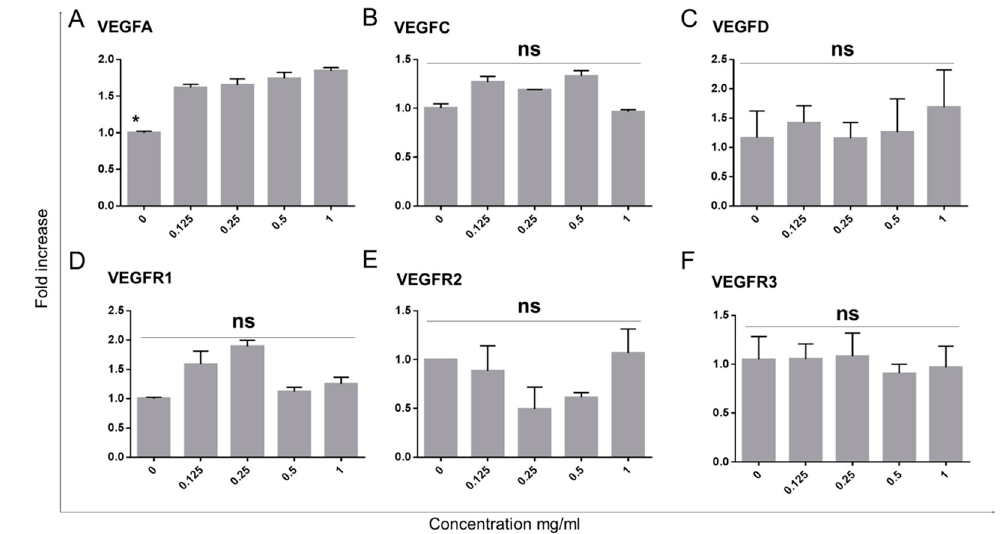
Figure 4. VEGFA expression of limbal epithelial cells is increased with Bevacizumab treatment while VEGFC, D and VEGFR1, 2 and 3 remain unchanged. VEGFA RNA expression exhibited a small (1.5-fold) but significant increase following Bevacizumab treatments ( A ). VEGFC and D were unchanged ( B , C ). No di ff erences were observed in the expression of VEGFR1, 2 and 3 ( D–F ). Number of replicates n = 3 and * p < 0.05.